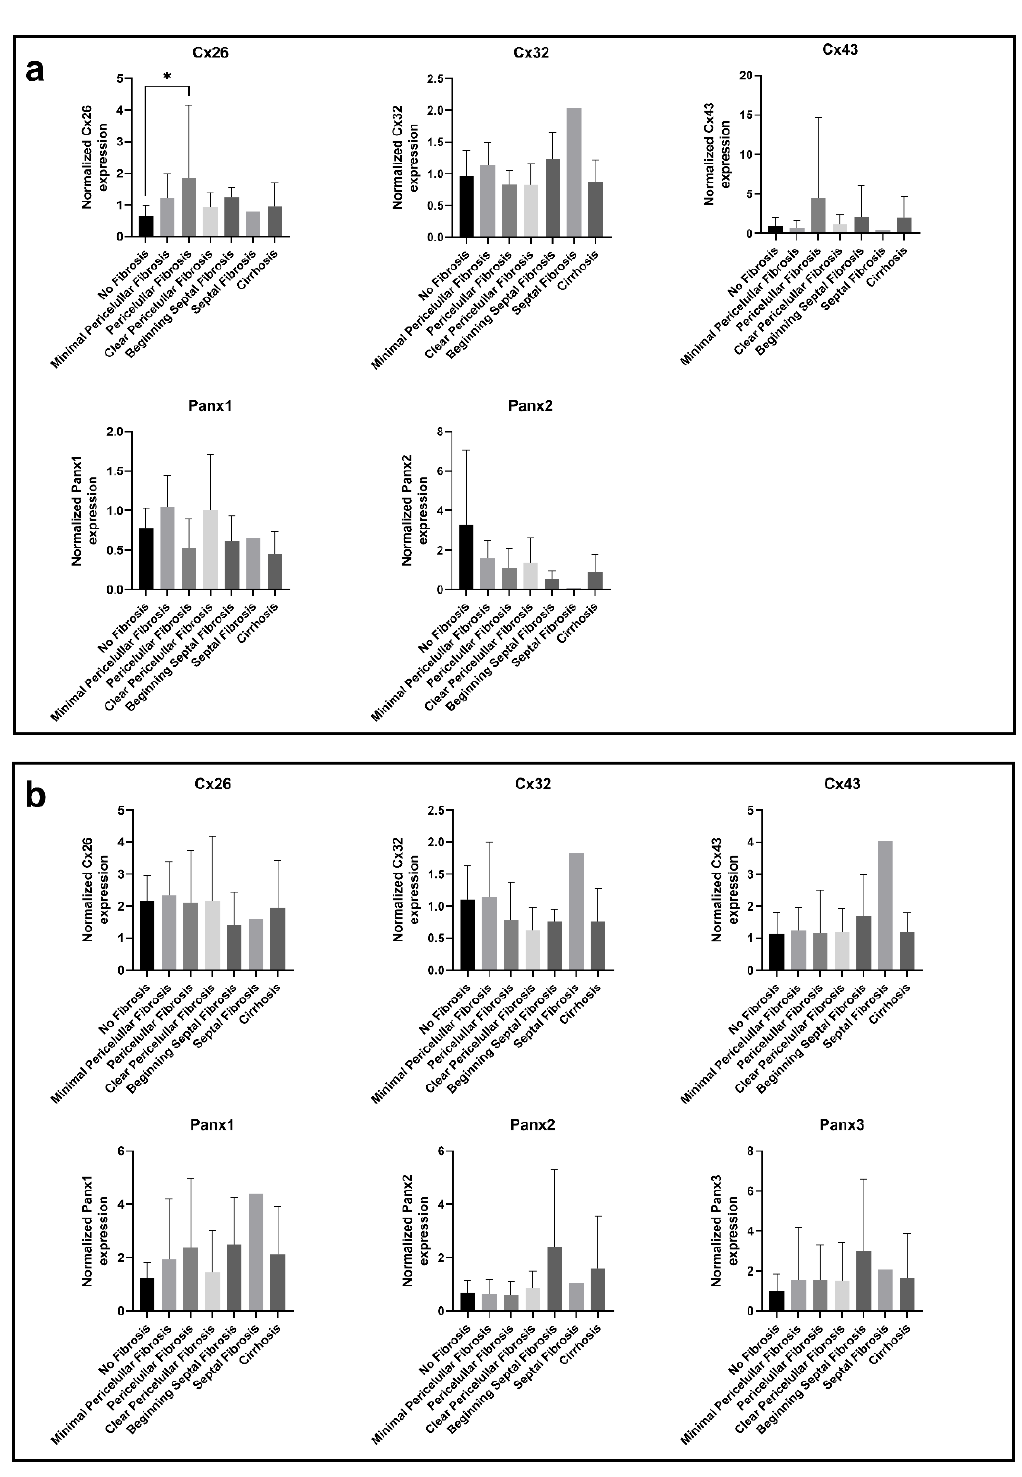
Figure 1: Cx and Panx gene (a) and protein (b) expression in human liver disease ranked by degrees of fibrosis. RT-qPCR analysis ( a ) and immunoblot analysis ( b ) of Cx26, Cx32, Cx43, Panx1, Panx2 and Panx3 was performed. Relative gene expression compared to a pooled sample was calcu- lated with the Pfaffl method (Pfaffl, 2001). Protein levels were normalized to the total protein loading and expressed as a ratio to a pooled sample. Samples with varying levels of fibrosis (RT-qPCR: N = 1-14, n = 2; immunoblot: N = 1-14; n = 1) were compared with an ordinary one-way ANOVA or Kruskal-Wallis test depending on the normality of the data distribution. Graphs display data as mean + SD with * p ≤